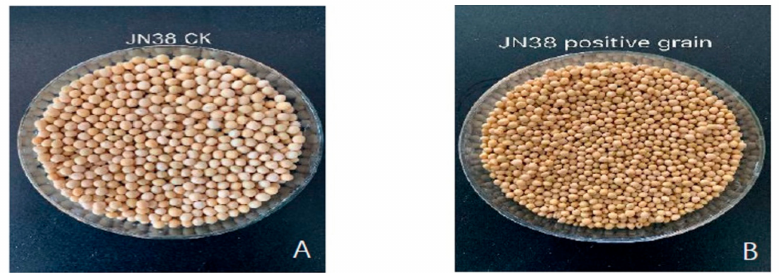
Figure 5. Grain size phenotype analysis. ( A ) JN38 o ff spring grain phenotype ( B ) Transgenic grain phenotype of CRISPR / Cas9